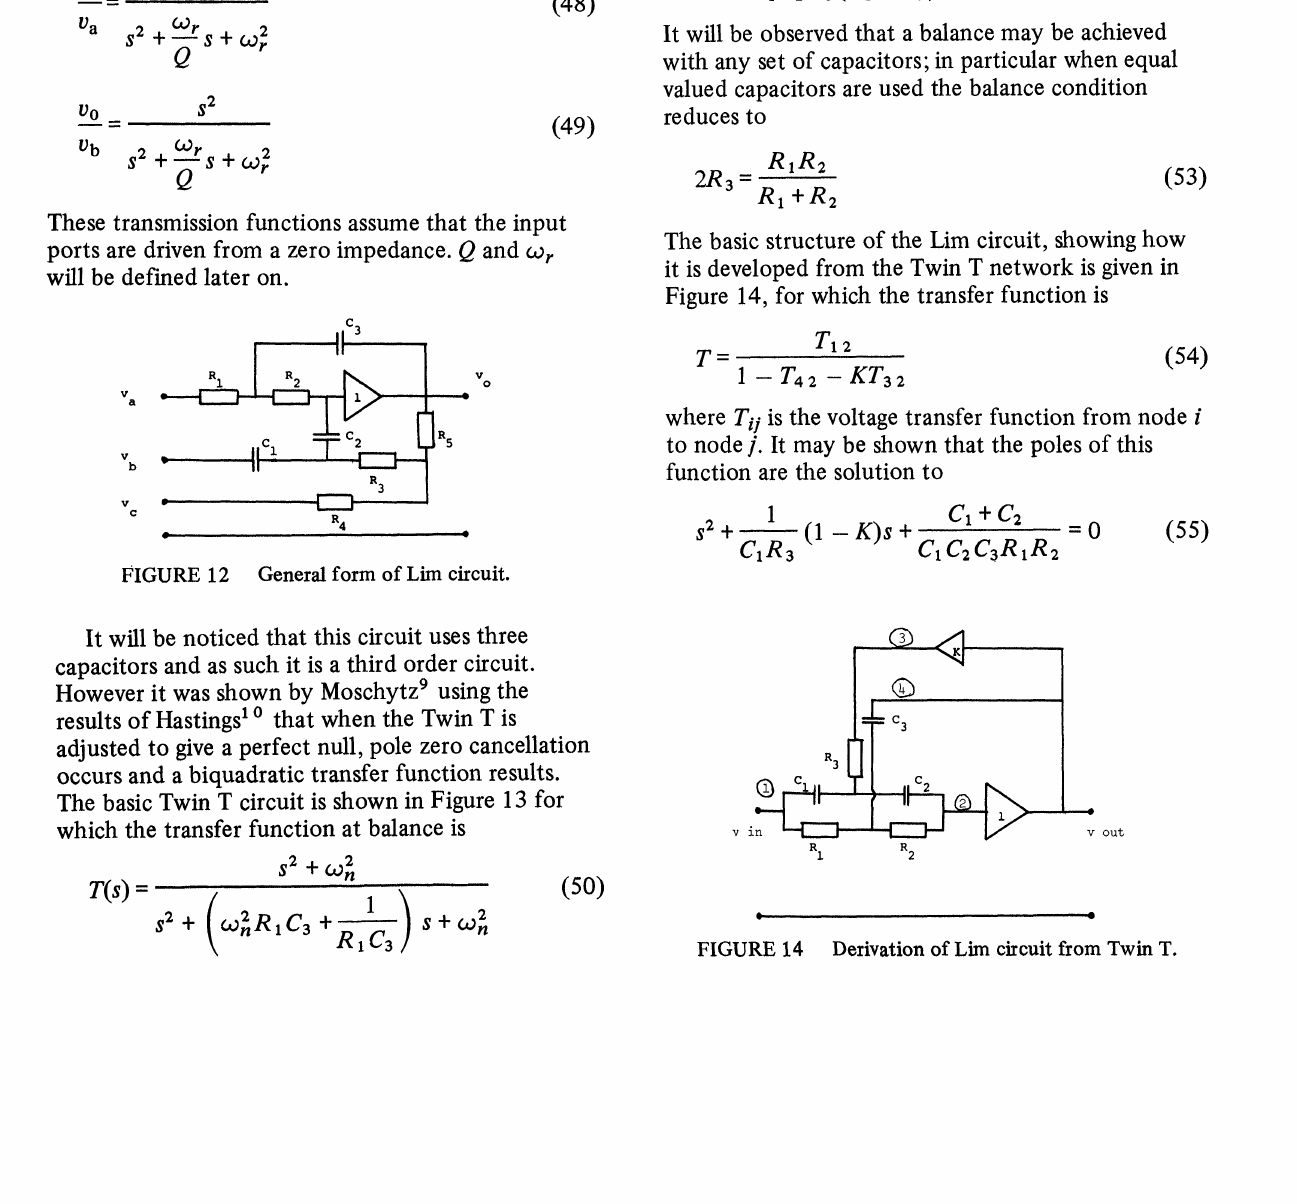
FIGURE 14 Derivation of Lira circuit from Twin